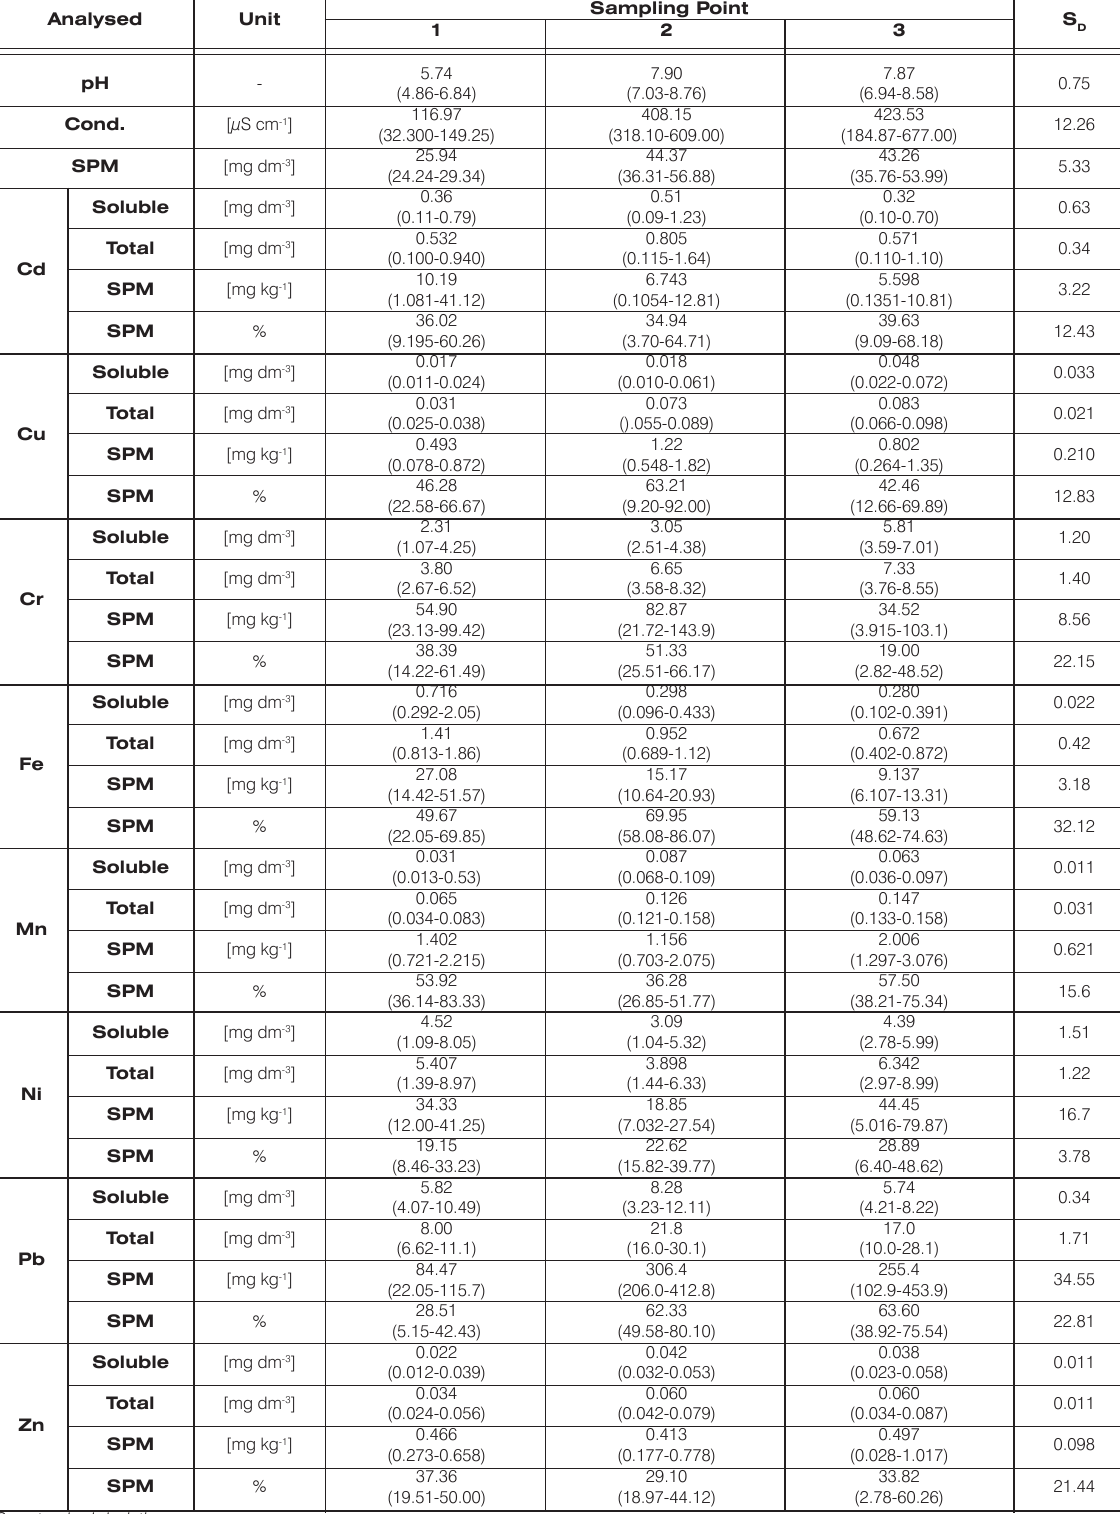
Table 2. Average (and min.–max.) values of analyses of the water samples in April 2009 – April 2010 ( n ≥